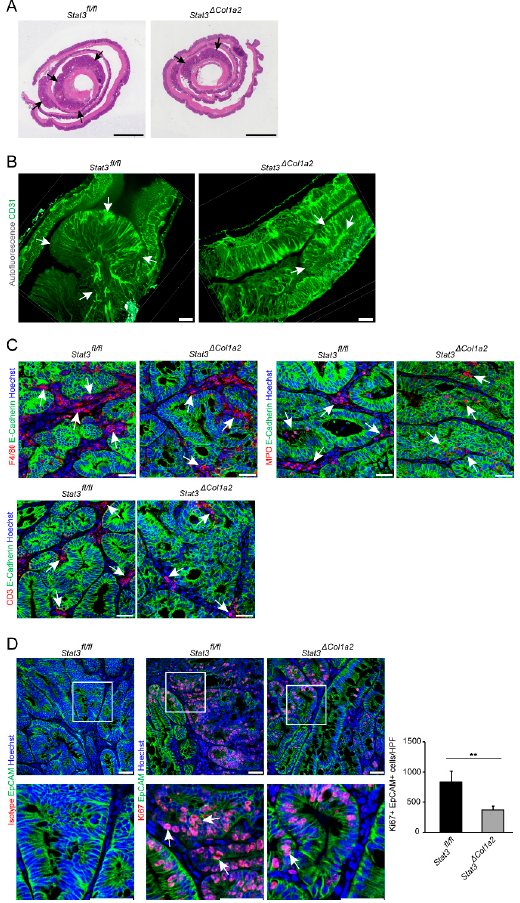
Figure 5. STAT3 inactivation in type I collagen-expressing fibroblasts decreases tumor cell prolifer- ation. ( A ) Colon tissue with AOM/DSS-induced tumors from Stat3 Δ Col1a2 mice and littermate controls was prepared as Swiss rolls, stained by H&E and examined by microscopy. Arrows indicate tumors. Scale bar: 2500 µm. ( B ) Colon tumors of the AOM/DSS model from Stat3 Δ Col1a2 mice and littermate controls were stained with a fluorescently labeled anti-CD31 antibody (green) and visualized by light sheet fluorescence microscopy. Autofluorescence is shown in grey. Arrows highlight tumors. Scale bar: 500 µm. ( C ) AOM/DSS tumors were obtained from Stat3 Δ Col1a2 mice and Stat3 fl/fl controls at day 64 and stained for immune cell markers (F4/80+, MPO+ or CD3+) and E-Cadherin as indicated. Arrows indicate infiltrating cells. Scale bar: 50 µm. ( D ) AOM/DSS tumor tissue (day 64 ) from Stat3 Δ Col1a2 mice and Stat3 fl/fl controls ( n = 3–4/group) was labeled by antibodies for Ki67 and EpCAM and analyzed by confocal fluorescent microscopy. For each sample, 4–5 representative HPFs were quantified. Arrows point to Ki67+EpCAM+ tumor cells. Scale bar: 50 µm. The data are representa- tive of at least two independent experiments. Quantitative data are shown as mean values ± SD. Significant differences are indicated (** p < 0.01).